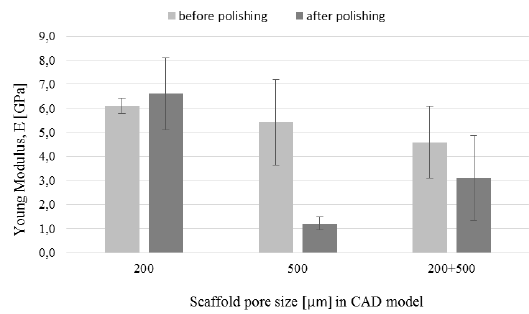
Figure 14. Scaffolds’ Young’s modulus before and after chemical polishing.